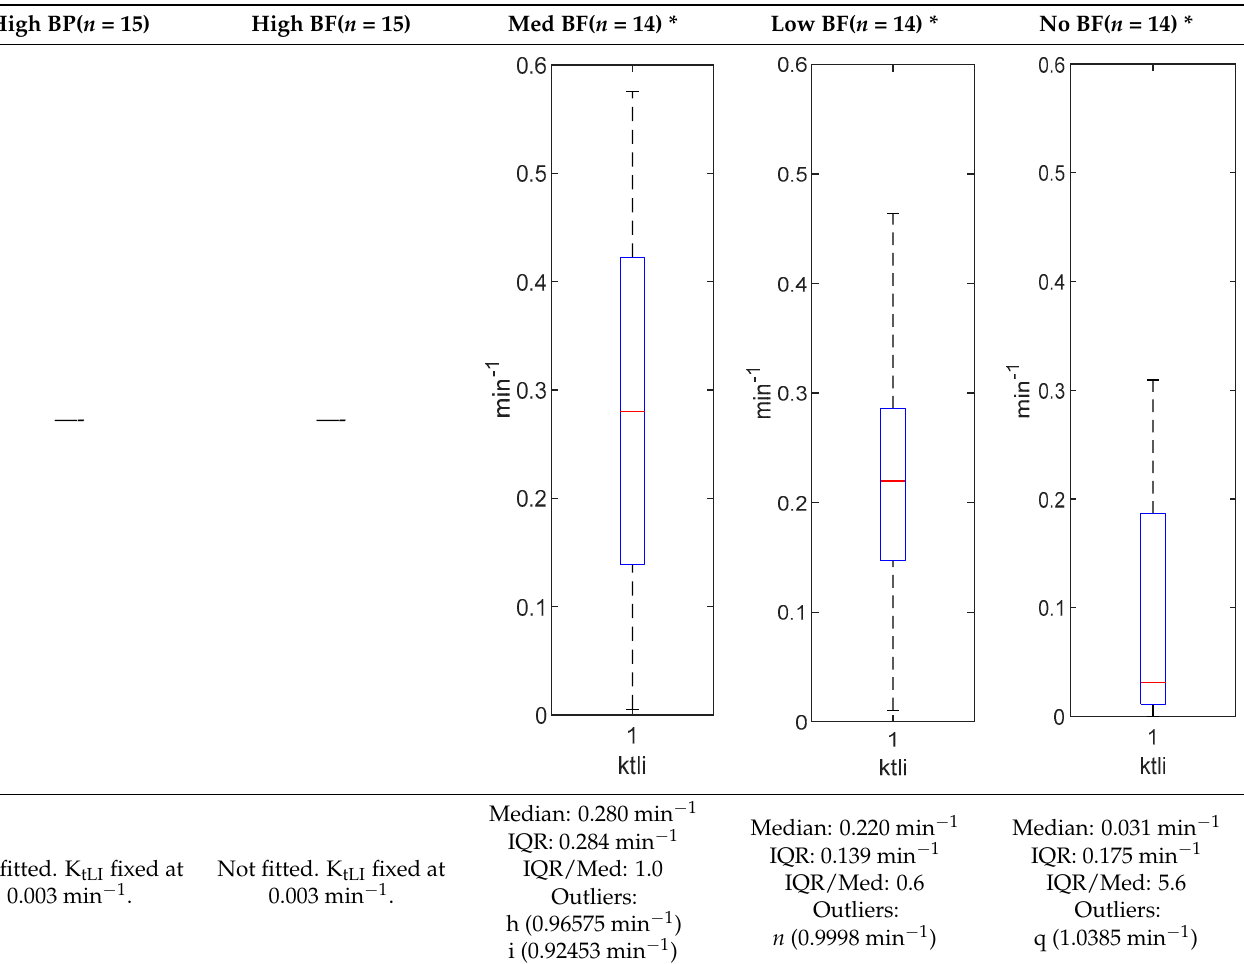
Table A3. k tLI estimation results.